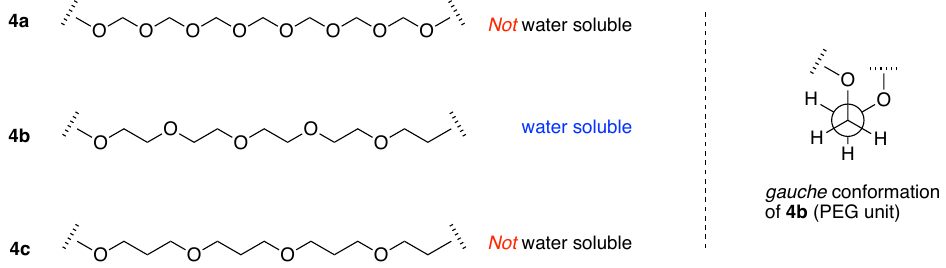
Figure 8. Solubility of the PEG unit ( 4b ) compared with two homologous oxyalkyl polymers ( left panel ), and the gauche conformational preference for PEG groups ( right panel ).